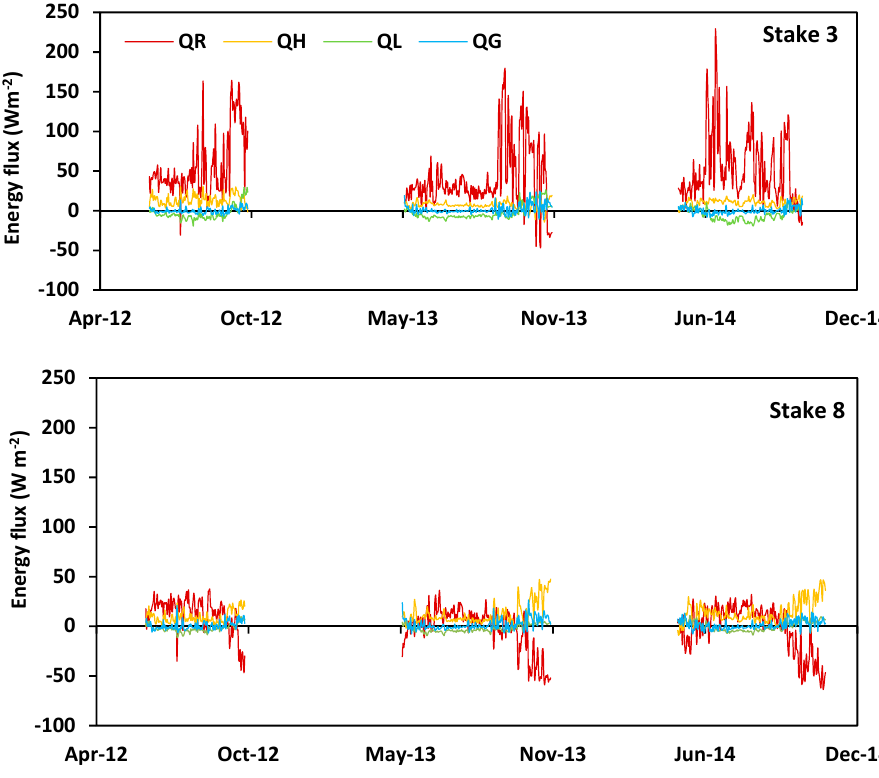
Figure 3. Daily mean values of energy balance components at stake locations 3 and 8 of Yala Glacier